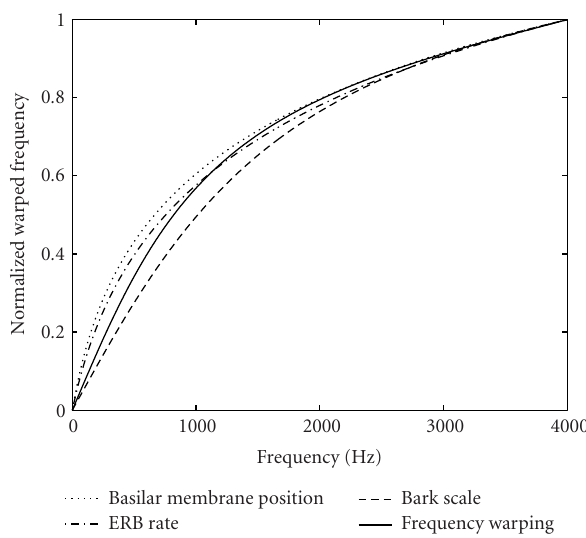
Figure 2: Comparison of the frequency-position mapping [17], the ERB rate [15], the Bark scale [50], and the frequency warping (see Appendix A.2) with λ = 0 . 5 for a sampling rate of 8kHz.